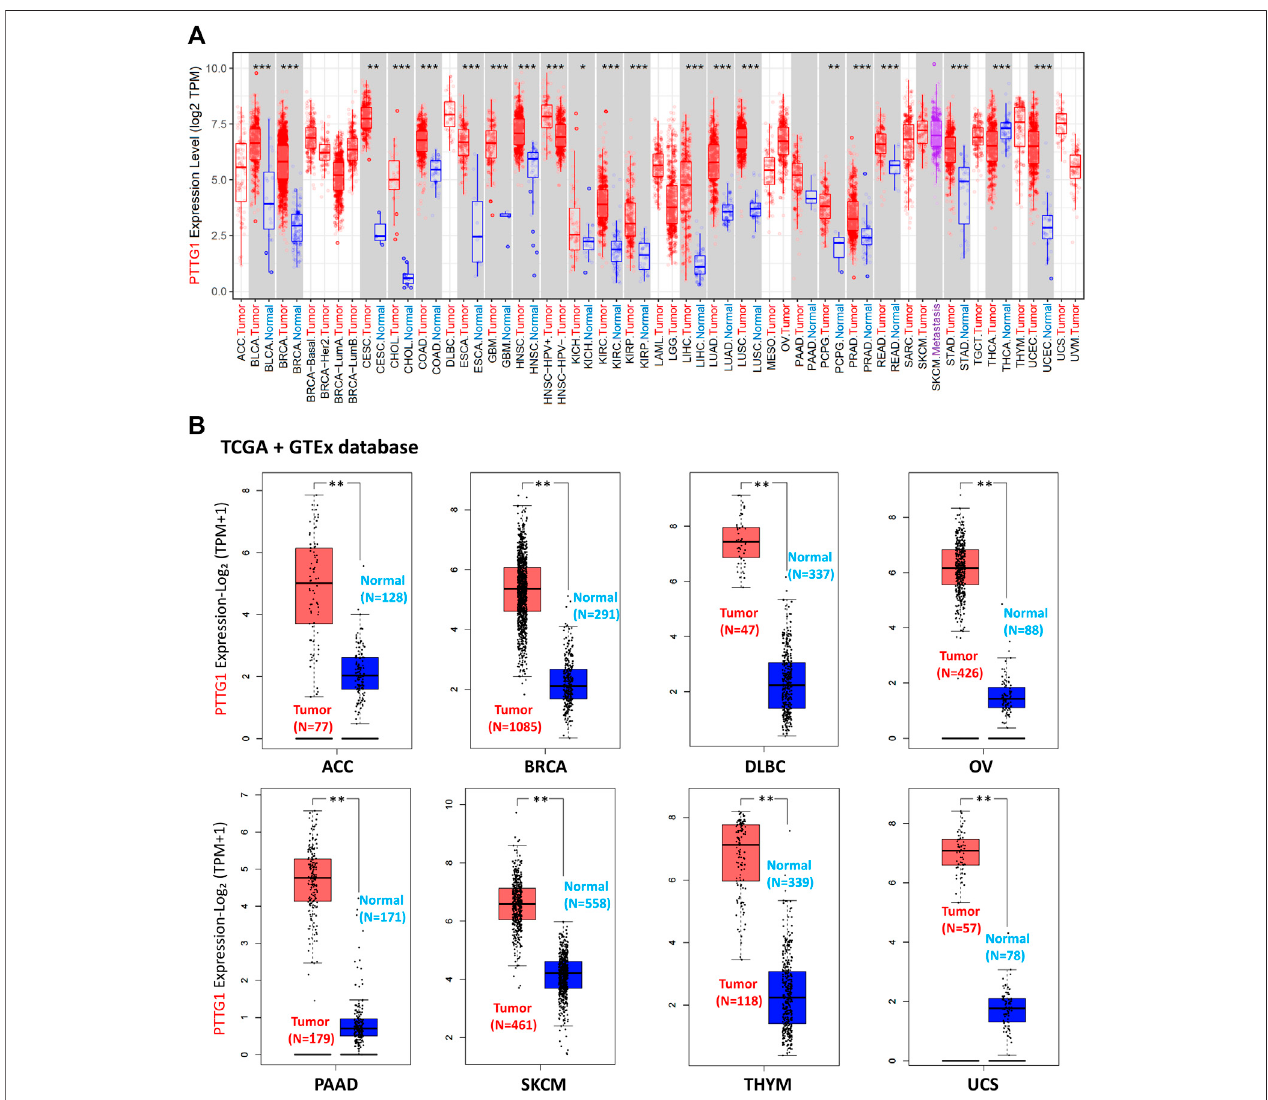
FIGURE3| Theexpression ofPTTG1 in differenttype oftumors at transcriptionlevel. (A) The PTTG1 expression indifferenttumors based on TCGA database. (B) The expression level of PTTG1 in various type of tumors based on the combination of TCGA and GTEx cohort. * p < 0.05, ** p < 0.01, *** p < 0.001.